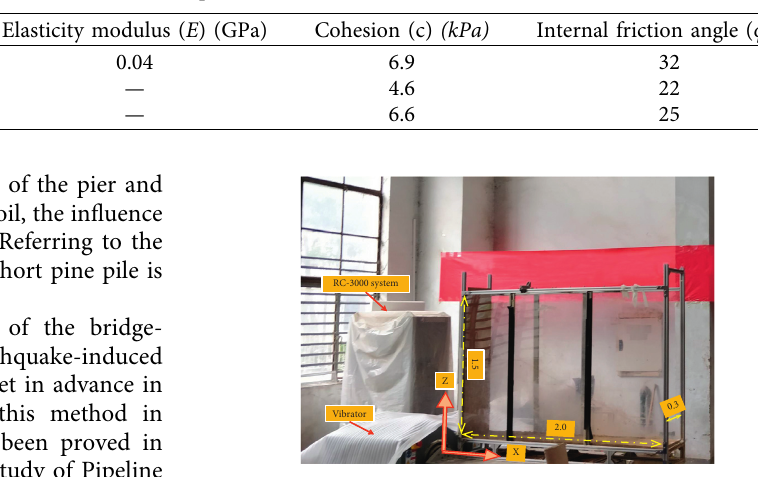
Table 3: Physical and mechanical parameters of similar materials.